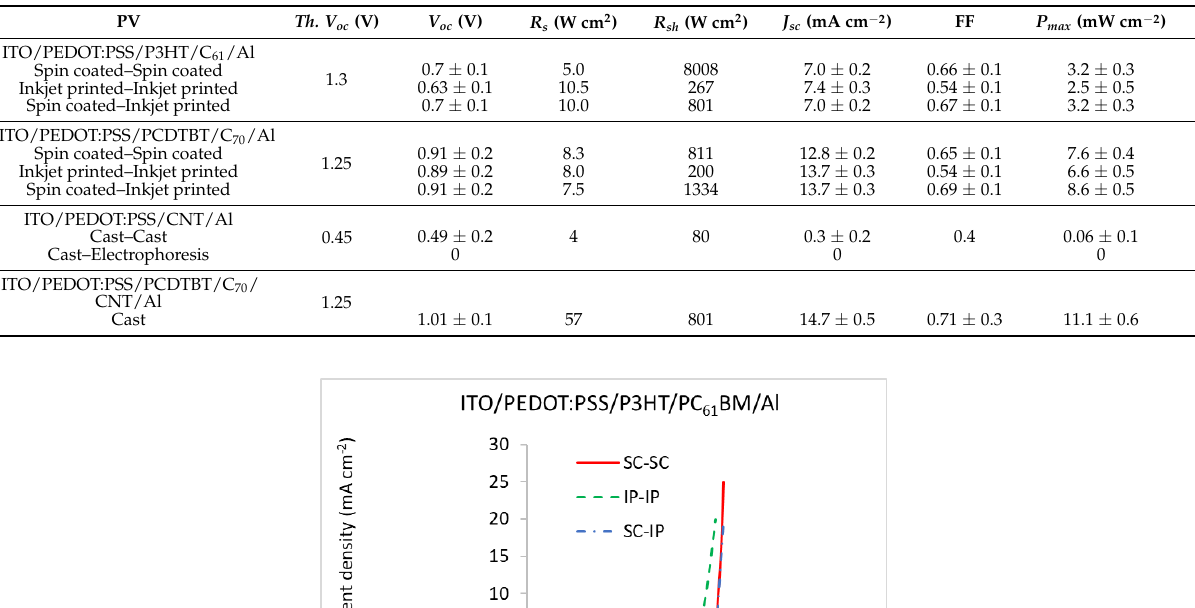
Table 1. Key performance parameters of the PV cells investigated in this paper: theoretical V oc according to Equation (3) and values of all parameters from the experimental testing of PV cells; each experimental value is the average of six tested cells, accompanied by the standard error.